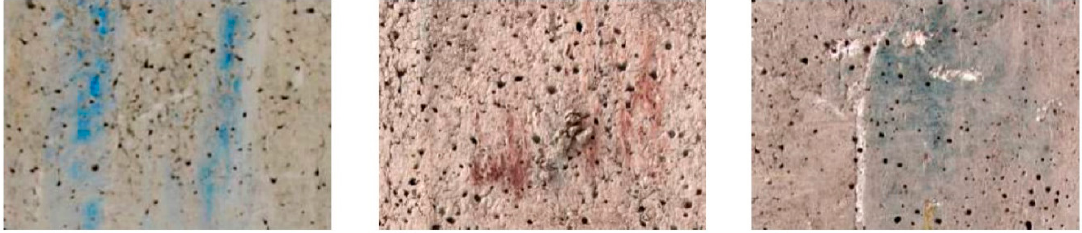
Figure 13. Detected marks and shadows on concrete surface.